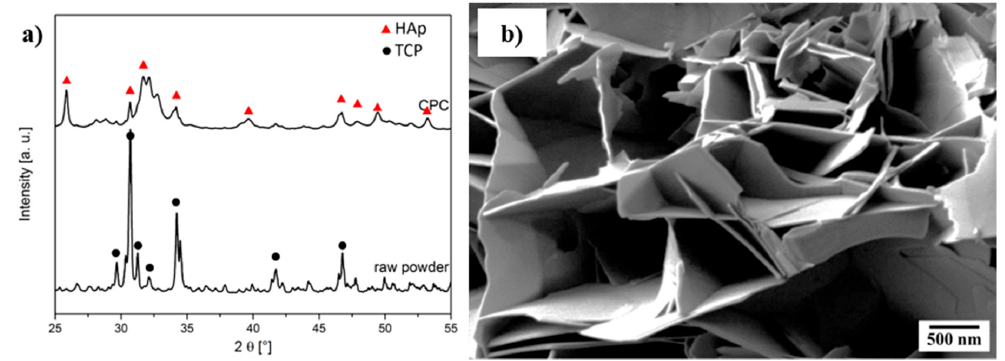
Figure 2. Characterization of ( a ) the phase composition of raw powders and set cement using X-ray diffraction and ( b ) the morphology of the cement matrix by scanning electron microscopy. Materials Table 1. Water contact angle of chemically treated fibers and setting kinetics of calcium phosphate cement (CPC) composites.